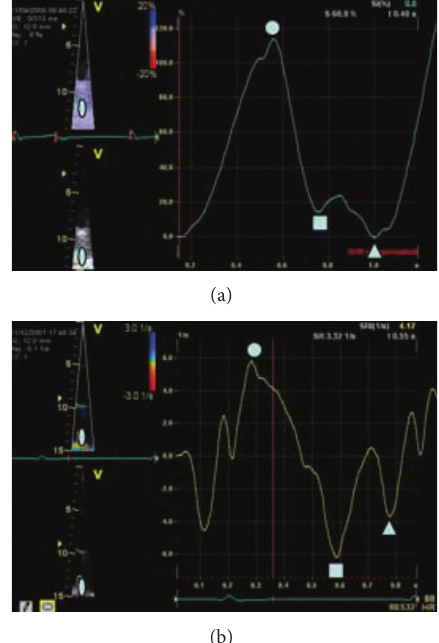
Figure 5: Left atrial strain (a) and strain rate (b) curves by Doppler. Left atrial reservoir function is studied by peak systolic value (ball), leftatrialconduitfunctionbypeakearlydiastolicvalue(square),and left atrial pump function by peak late diastolic value